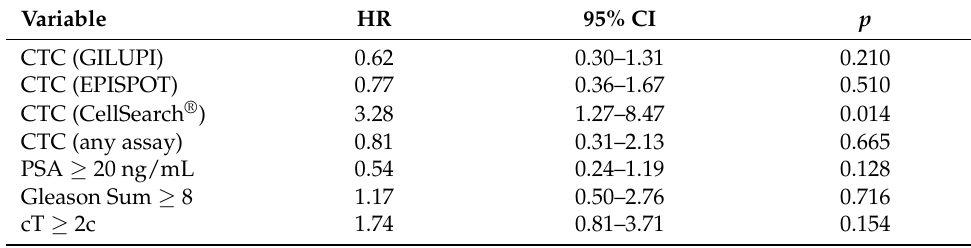
Figure 3. OS estimates in 85 patients with localized PCa at baseline: ( a ) entire cohort; ( b ) by baseline CTC count ≥ 1 determined with the CellSearch ® system. Table 7. Univariate analyses for OS in 85 patients with localized PCa at baseline. Variable